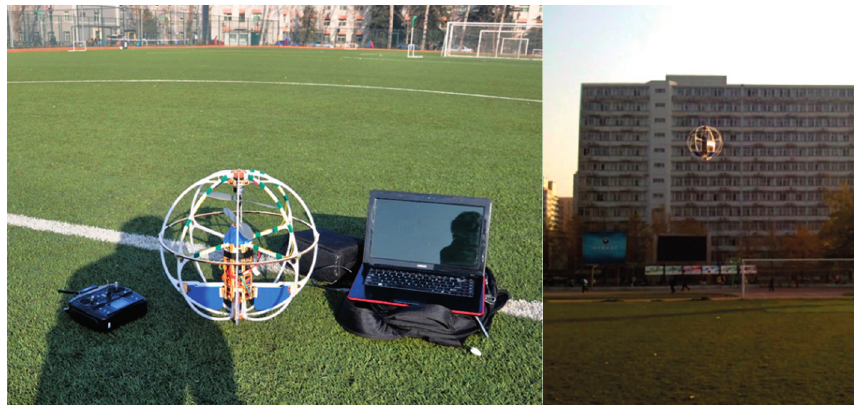
Figure 8. The flying test on the football